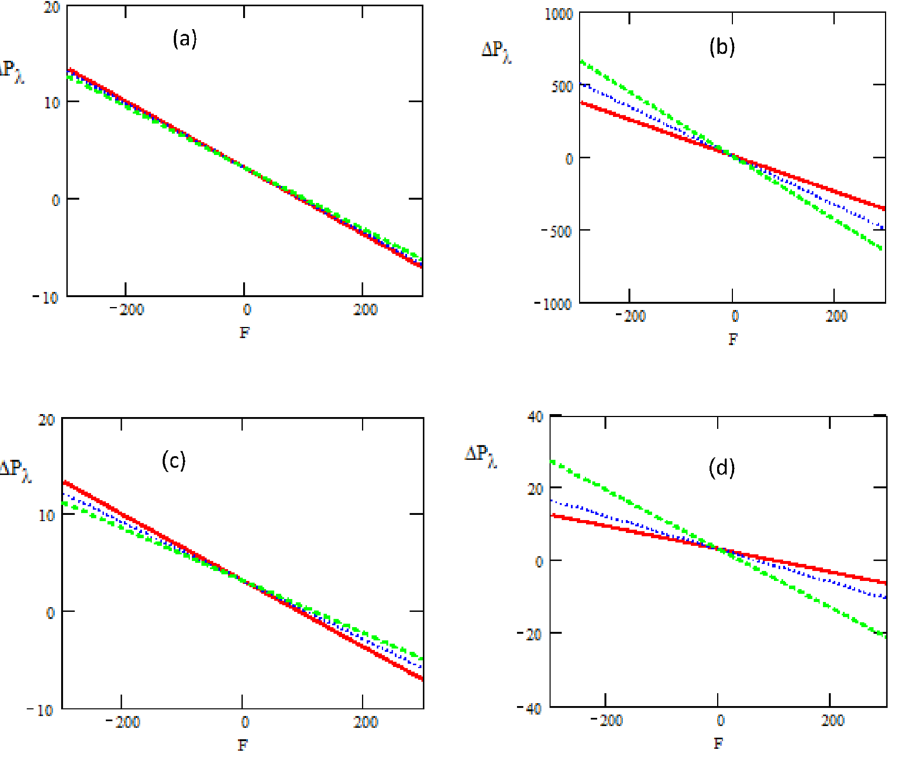
Figure 8. The pressure rise concerning the axial-F with different values of ( a